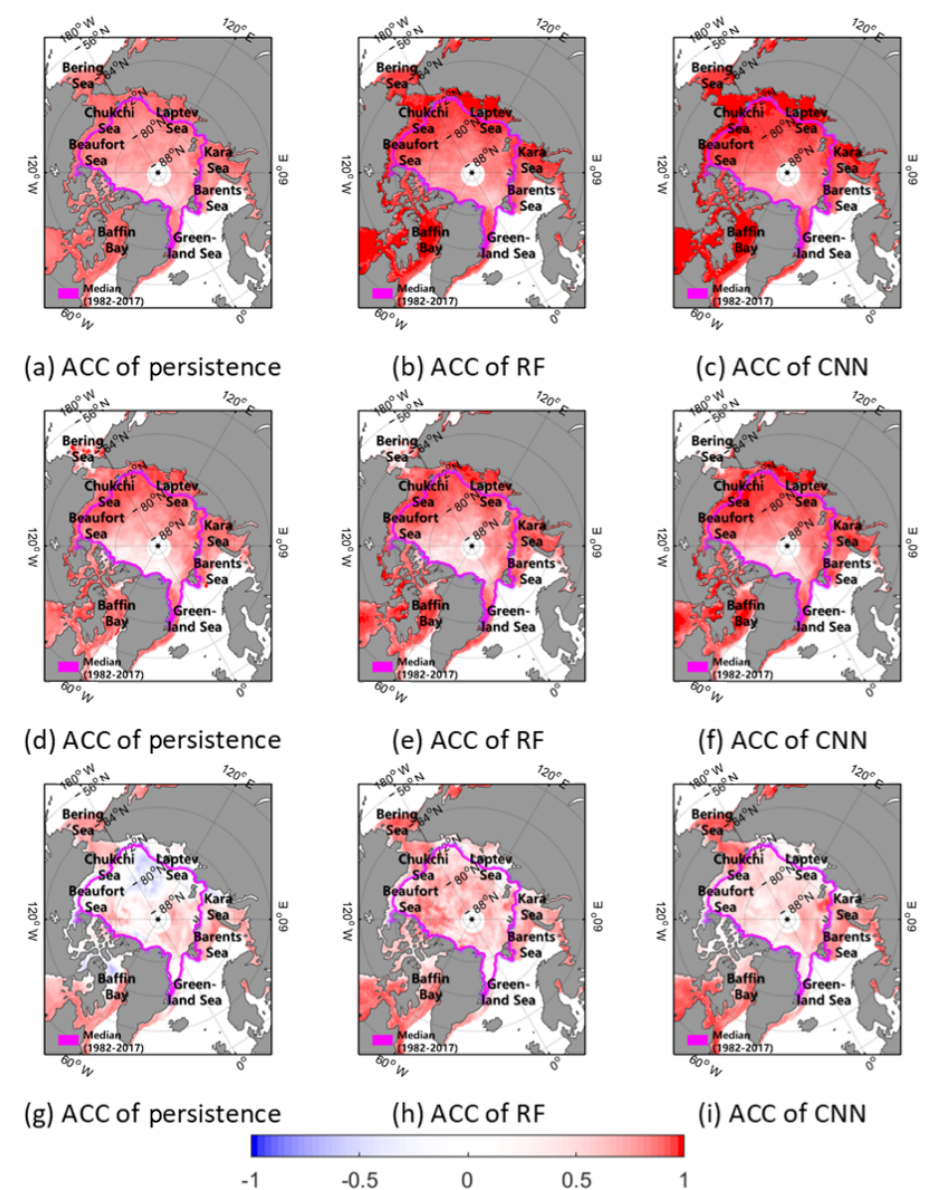
Figure 3. The temporal ACC of the persistence (a) , RF (b) , and CNN (c) during 2000–2017. As in (a–c) but for the melting (June–September) and freezing (December–March) seasons, shown in (d–f) and (g–i) , respectively.